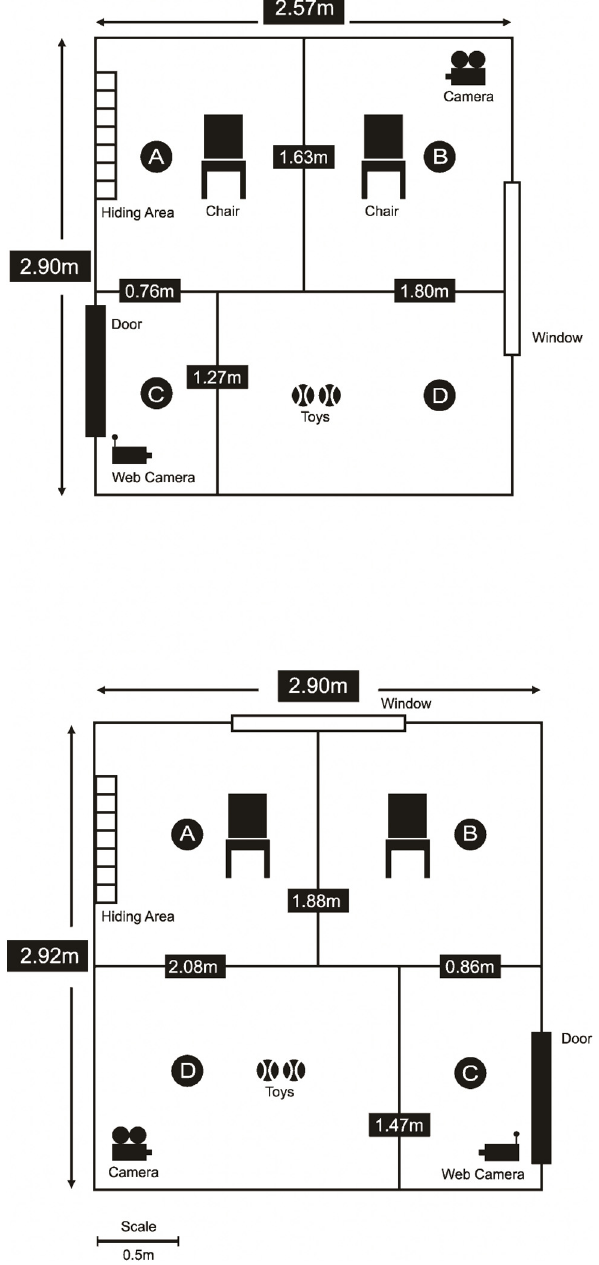
Fig 1. Graphical illustration of layout and dimensions of testing rooms (1) and (2), Each room was divided into four areas A) owner/stranger, B) owner/stranger, C) door, D)